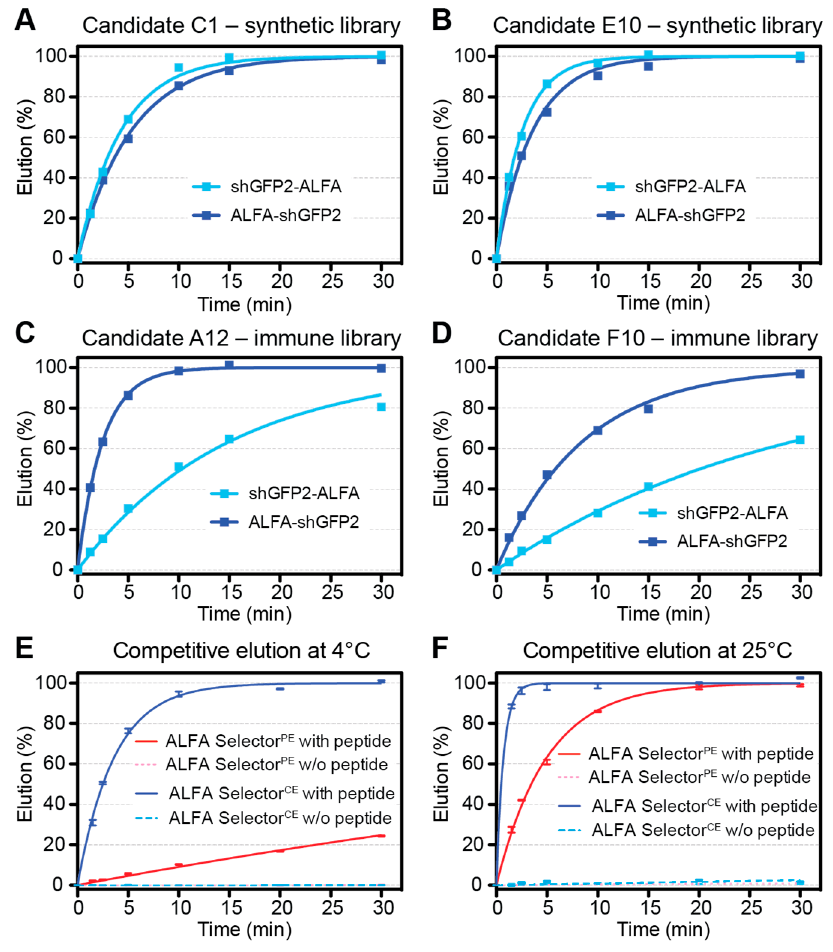
Figure 2. Kinetic characterization of NbALFA CE candidate clones. ( A – D ): Selected NbALFA CE candidates were immobilized on an agarose-based resin. All resins were charged with either shGFP2-ALFA (light blue curves) or ALFA-shGFP2 (dark blue curves). Upon competitive elution in batch mode using 200 μ M ALFA peptide at 4 °C, target protein elution was quantified by measuring the fluorescent material released into the supernatant. ( E , F ): ALFA Selector PE (PE, red curves) and ALFA Selector CE based on candidate clone C1 (CE, blue curves) were charged with shGFP2-ALFA and subjected to competitive peptide elution at 4 °C ( E ) or 25 °C ( F ), respectively. Parallel reactions without addition of peptide served as controls (dotted red and dotted blue curves). Elution was quantified as described for panels ( A – D ). The data points show mean values from four independent experiments including standard deviations. Curves represent fits to first ‐ order association kinetics.